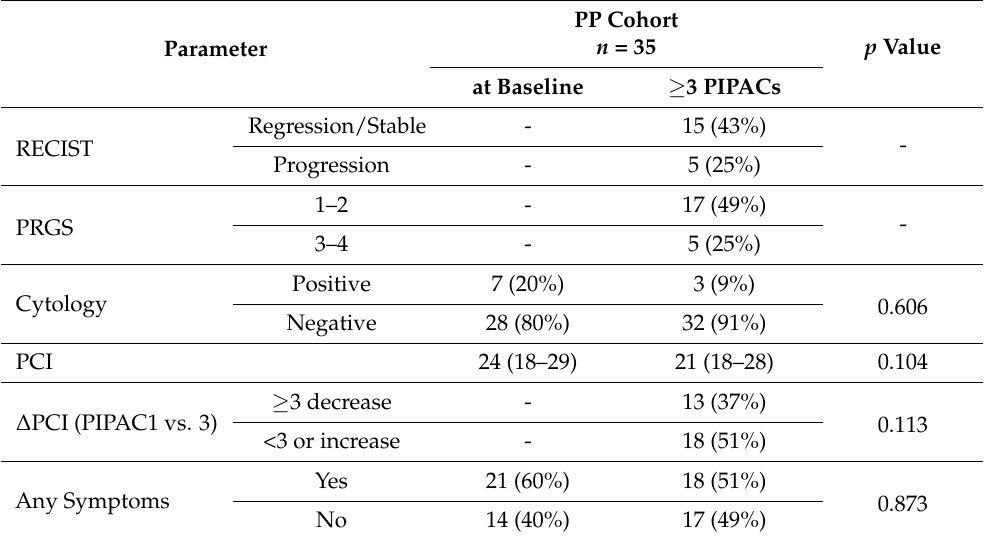
Table 2. Treatment response of patients undergoing Pressurized IntraPeritoneal Aerosol Chemother- apy for peritoneal metastases of appendiceal